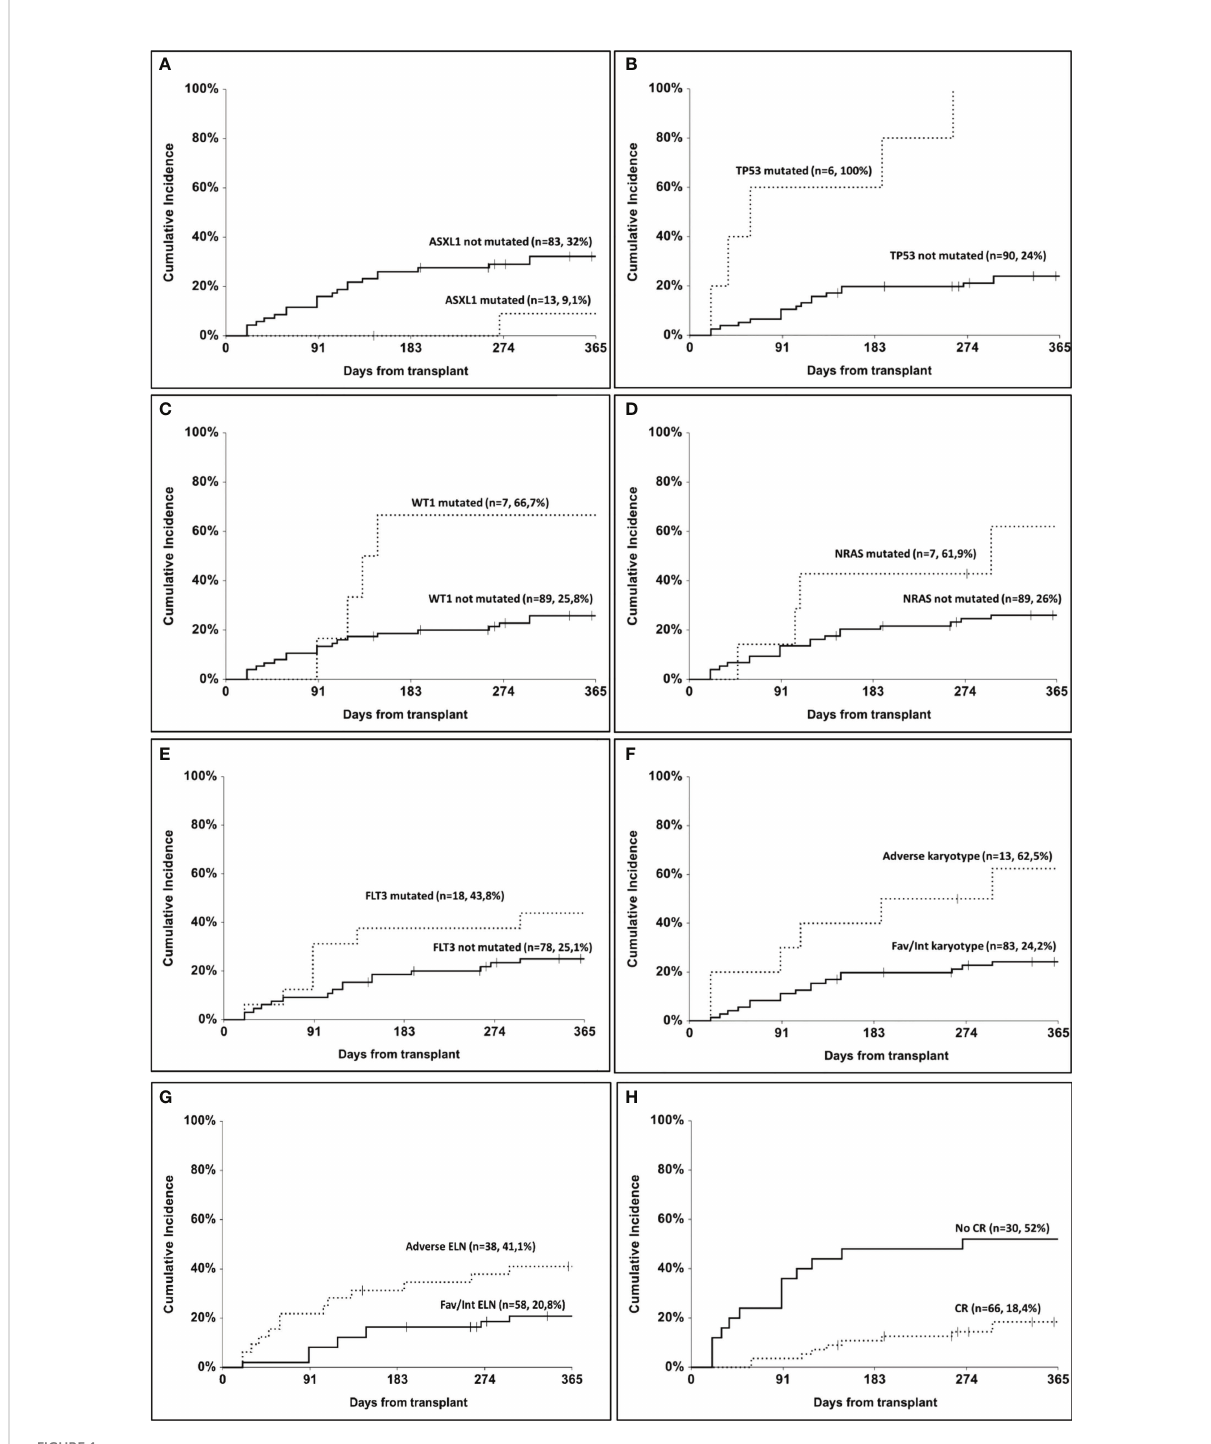
FIGURE 1 One-year cumulative incidence of relapse. (A) according to ASXL1 mutation; (B) according to TP53 mutation; (C) according to WT1 mutation; (D) according to NRAS mutation; (E) according to FLT3 mutation; (F) according to cytogenetic risk; (G) according to ELN risk; (H) according to remission status at